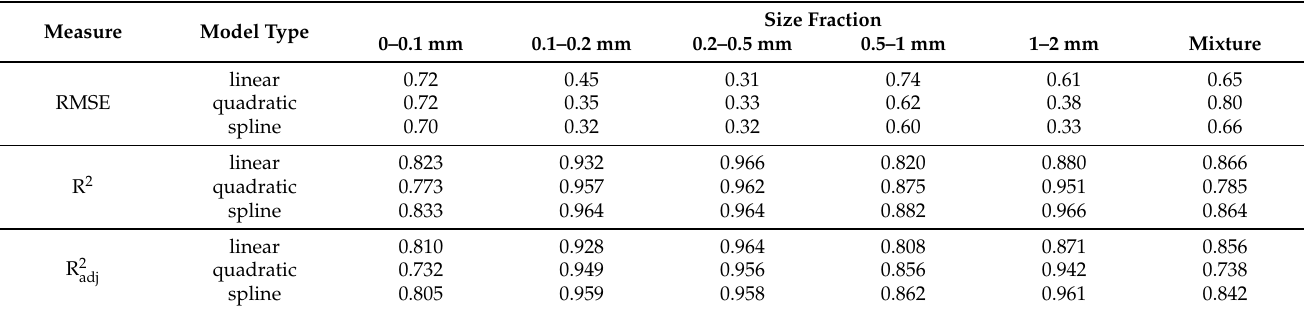
Table 3. Goodness of fit of estimated moisture (output of inverse models) to true moisture (reference measurements). Quality indices calculated according to Appendix